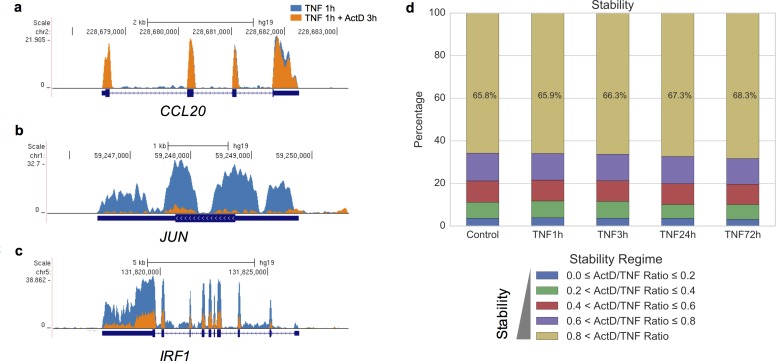
Genome-wide evaluation of mRNA stability states of expressed genes in RA FLS.(a-c), Gene tracks showing sequencing reads from RNA sequencing mapped to CCL20 (a), JUN (b) and IRF1 (c) genes. The sequencing reads after TNF stimulation for 1 hour without (blue) or with Act D (orange) are shown. (d), Stacked bar graphs illustrating the mRNA stability states of genes expressed in unstimulated (Control) and TNF-stimulated FLS (1, 3, 24 and 72 hours of TNF stimulation). The mRNA stability status was calculated as the ratio of expression levels at the TNF+Act D condition divided to the expression levels at the TNF condition. This ratio ranges from 0 to 1 and classifies genes to a spectrum from very unstable to very stable transcripts. The expressed genes were classified into five groups with distinct stability states and the size of each group is represented as % of total number of expressed genes for each condition.